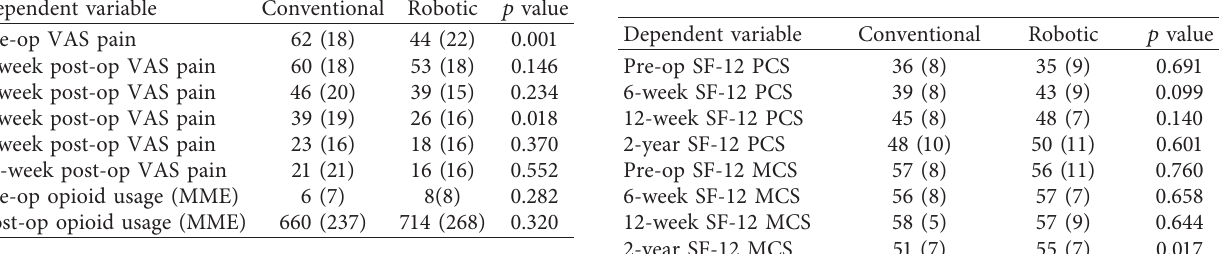
Table 4: A summary of VAS scores and opioid usage. Table 5: Preoperative and postoperative SF-12 PCS and SF-12 MCS